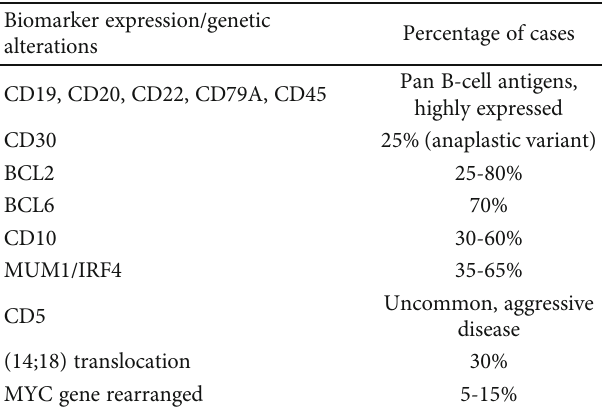
Table 1: A listing of DLBCL diagnostic markers [4, 6]. Biomarker